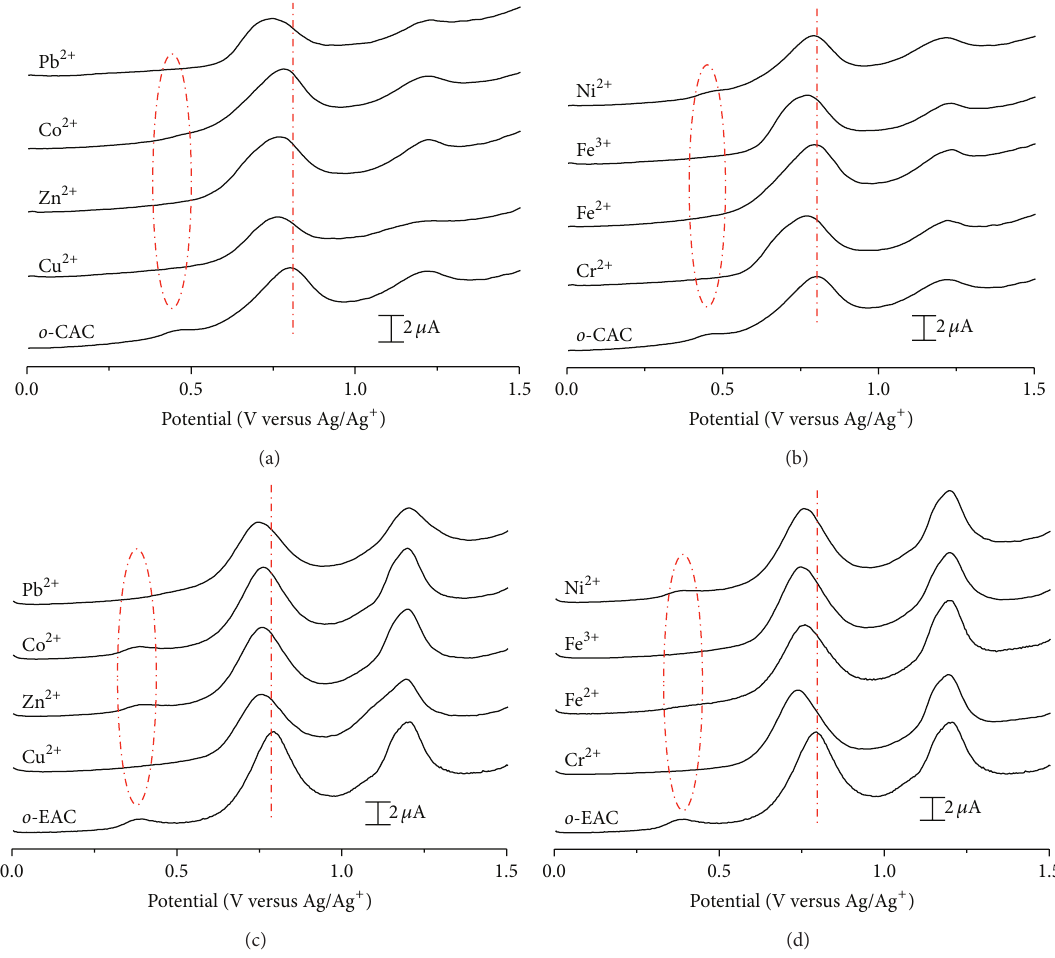
Figure 4: DPVs of ((a), (b)) o -CAC (1 × 10 −4 M) and ((c), (d)) o -EAC (1 × 10 −4 M) in the absence and presence of transition metal ions (1 ×